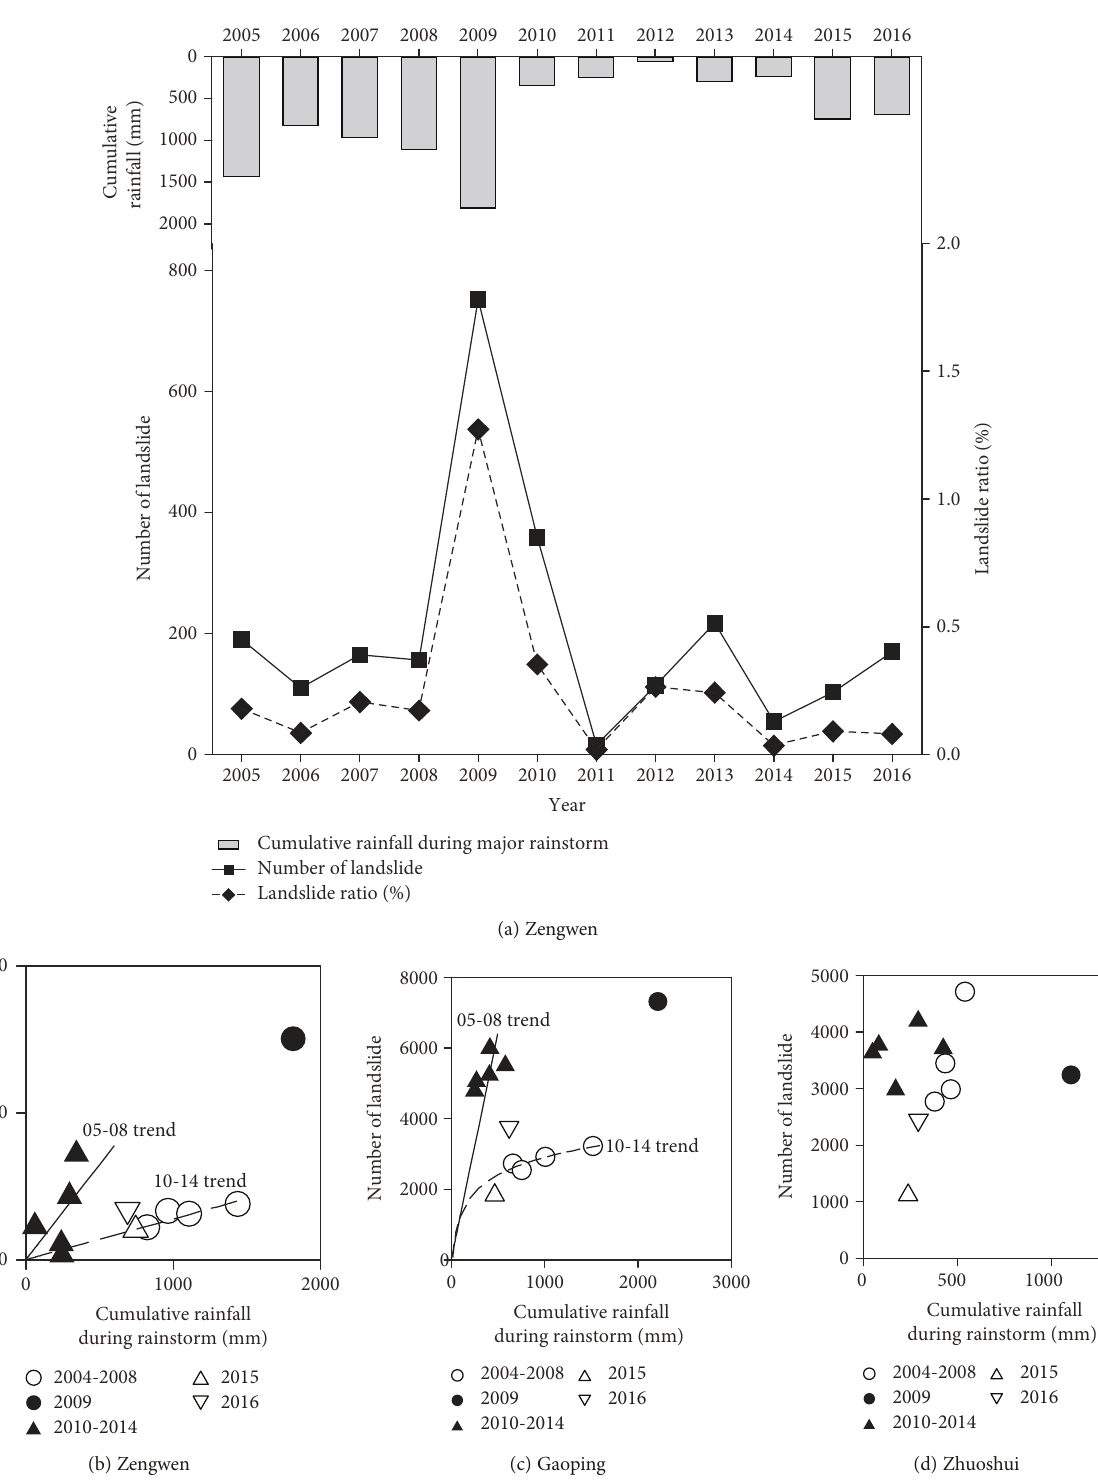
Figure 5: (a) The variations of landslides during 2005 – 2016 in the Zengwen River catchment. (b – d) The relationships between the landslide number and cumulative rainfall in the Zengwen River, Gaoping River, and Zhuoshui River